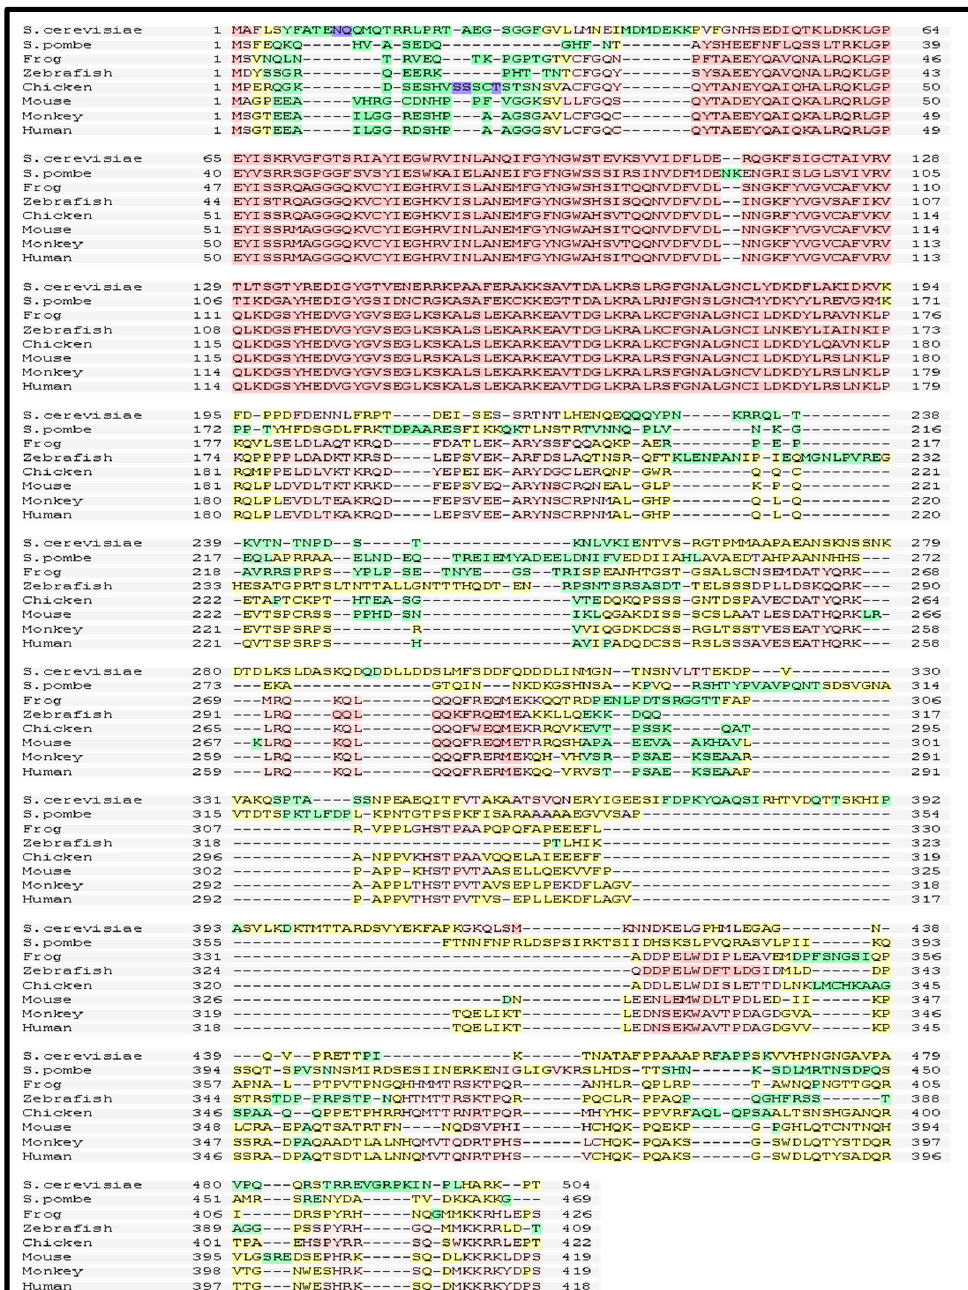
Figure 3. Sequence conservation of RAD52 orthologs. The RAD52 aa sequences from Saccharomycescerevisiae, Saccharomyces pombe (RAD22) , frog ( Xenopus laevis ), zebrafish ( Danio rerio ),